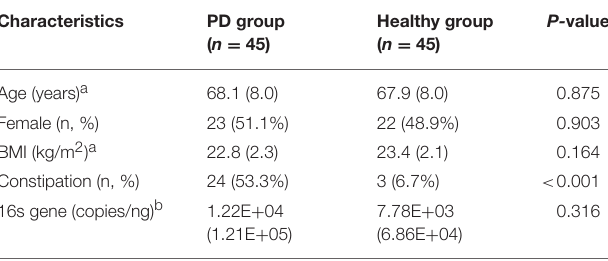
TABLE 2 | Characteristics of the study subjects.